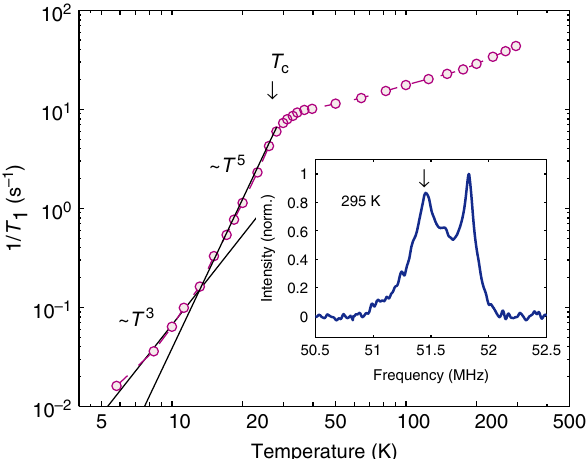
Fig. 4 NMR relaxation rate and lineshape. Temperature dependence of 1/ T 1 relaxation rate measured at 7 T at the left peak of the 75 As NMR lineshape ( arrow in the inset). A similar 1/ T 1 behavior is found also for the right peak. The steep decrease of 1/ T 1 below T c is compatible with a fully gapped superconductor. Lines indicate different power-law dependences, at different temperature regimes (see text for details) only a marginal increase ( < 5%) in FWHM below 35 K, hence